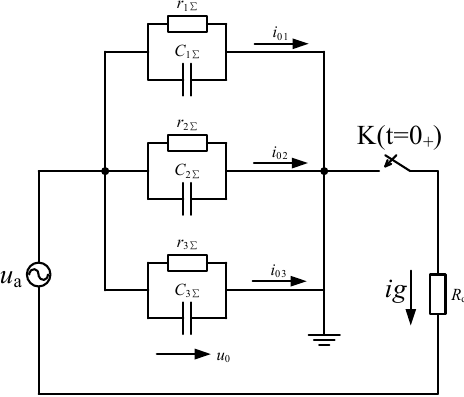
Figure 4. Single-phase earth leakage thumbnail Figure in a no-grounding system and its sampling method.